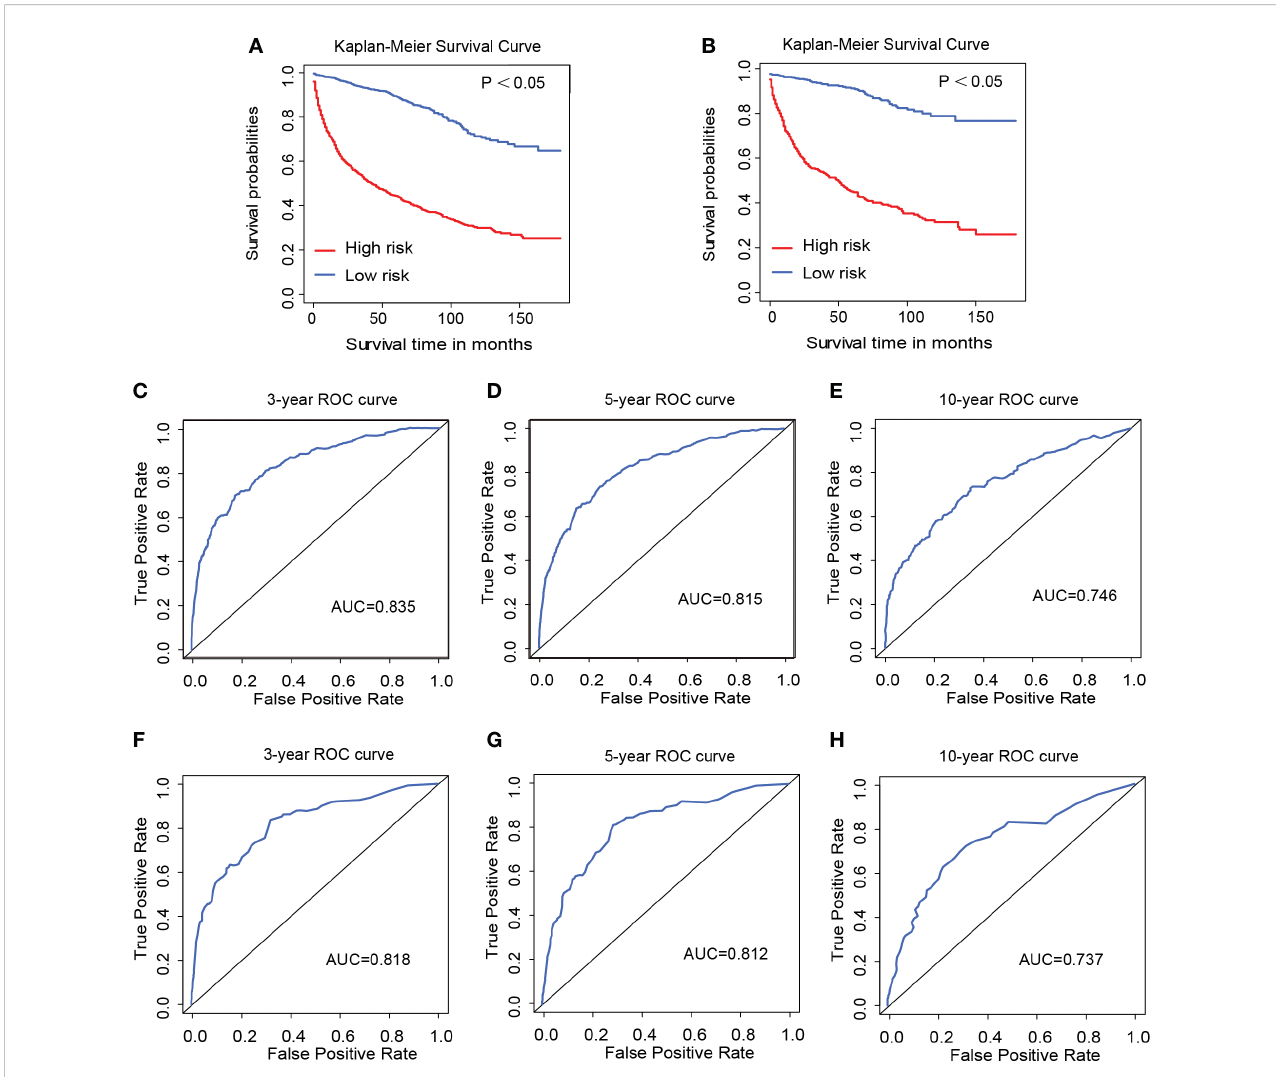
FIGURE 4 Kaplan – Meier survival curves of the training group (A) and validation group (B) . The 3-year (C) , 5-year (D) , and 10-year (E) ROC curves of the training group and the 3-year (F) , 5-year (G) , and 10-year (H) ROC curves of the validation